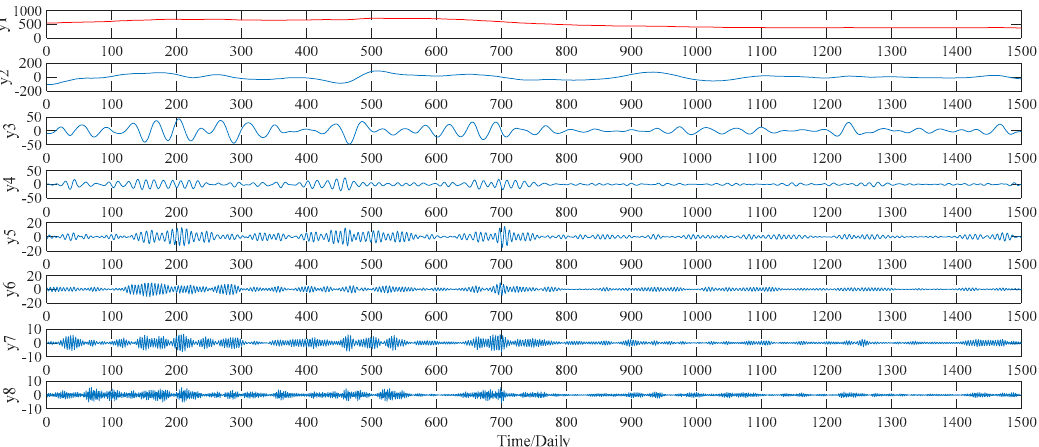
Figure 15. Decomposition results of the ITD method (corn).